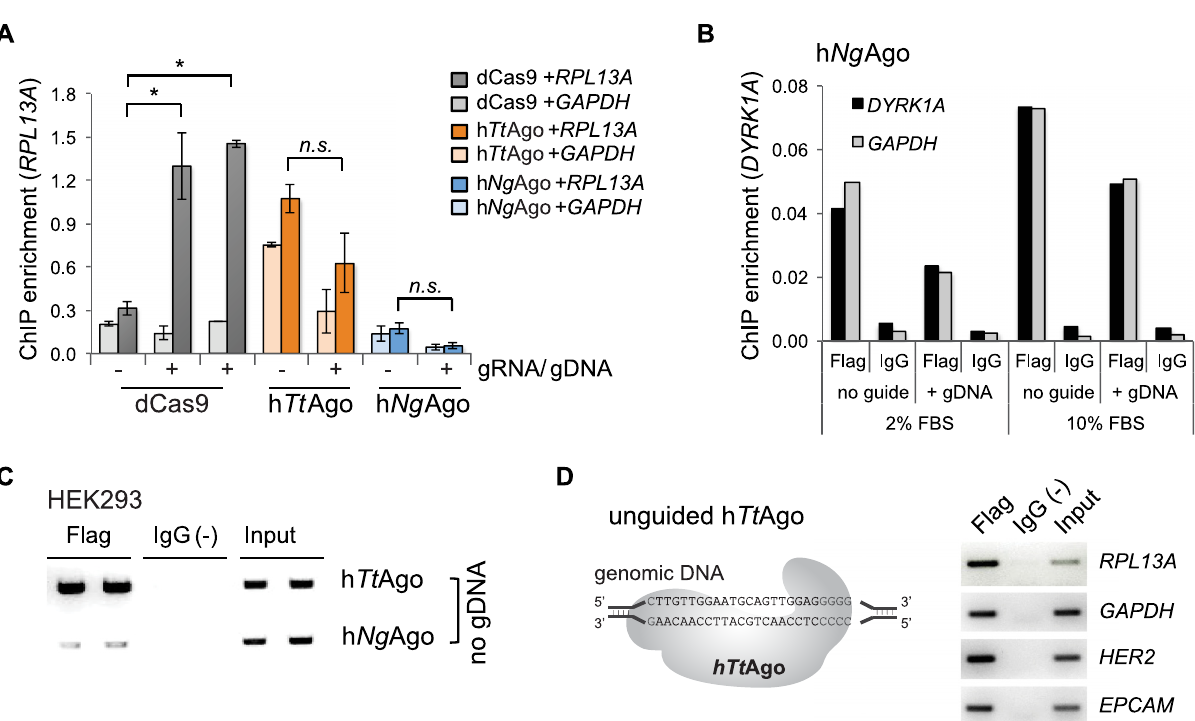
Fig 3. DNA guides do not facilitate binding of h Tt Ago and h Ng Ago to genomic target loci. A. ChIP-qPCR enrichment to quantitate binding to RPL13A locus. HEK293 cells were transfected with h Tt Ago- and h Ng Ago-expression plasmids either with (+) or without (-) gDNAs. dCas9 and two different gRNA expressing plasmids were co-transfected as controls (Student two-sided T -test; (cid:3) , p < 0.05; n . s ., not significant; n = 2 independent experiments; mean ± SEM). Binding to a non-target locus (GAPDH) was evaluated to interrogate binding specificity. B. Targeted binding of h Ng Ago failed at the DYRK1A locus in HEK293 cells. HEK293 cells were co-transfected with h Ng Ago expression plasmid together with 24-nt 5’-phosphorylated gDNAs (G5 gDNA) or without gDNA. ChIP assays were performed with an antibody to the 3xFlag tag of h Ng Ago or with rabbit IgG as a negative control. Addition of G5 gDNA that was targeted to the DYRK1A locus did not increase h Ng Ago binding above background level (no guide). There was no difference in binding to DYRK1A or to a control region ( GAPDH ). Two conditions (2% or 10% FBS in growth media) were tested. C. ChIP-PCR to measure unguided h Tt Ago and h Ng Ago binding to the RPL13A locus. ChIP assays were performed with two biological replicates. Flag, Flag ChIP; IgG (-), IgG negative control; Input, 0.1% chromatin input. D. h Tt Ago binds multiple genomic regions without gDNA in HeLa cells. ChIP assays were performed in HeLa cells expressing h Tt Ago without DNA guides. Standard PCR with locus-specific primers demonstrated h Tt Ago binding to RPL13A , GAPDH , HER2 and EPCAM .Flag, Flag ChIP; IgG(-), IgG negative control; Input, 0.1% chromatin input.